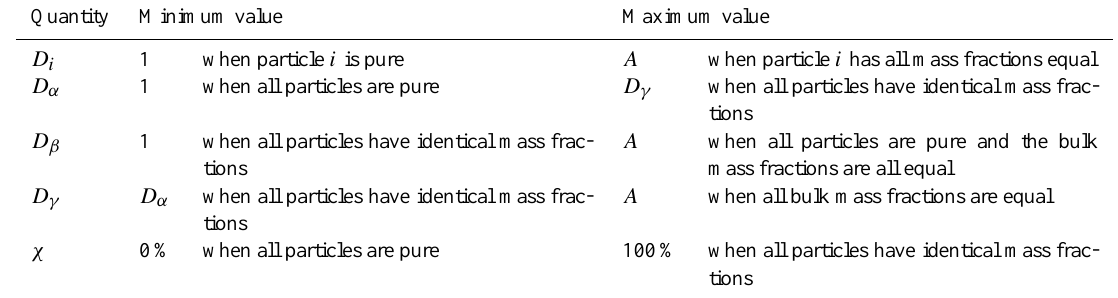
Table 3. Conditions under which the maximum and minimum diversity values are reached. See Fig. 2 for a graphical representation of this information, and see Theorem 1 for precise